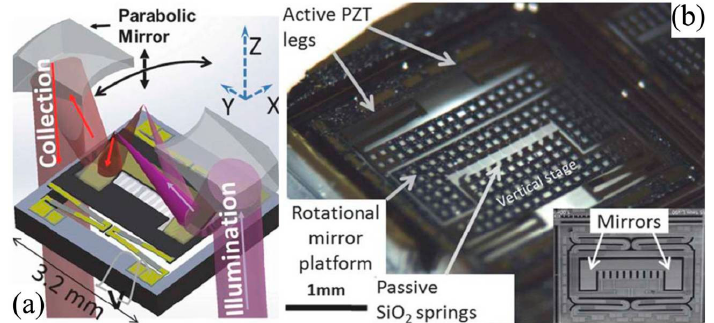
Figure 12. Vertical-rotational MEMS scanner for dual-axis confocal endomicroscope with XZ cross-sectional imaging: ( a ) schematic of the outer diameter 5.5 mm packaging; and ( b ) vertical-rotational micro-scanner based on active outer vertical displacement and passive inner resonant scanning. Inset: SEM, variant with a solid dog-bone shaped mirror surface for dual-axis confocal endomicroscope (Reproduced with permission from IEEE [85]).